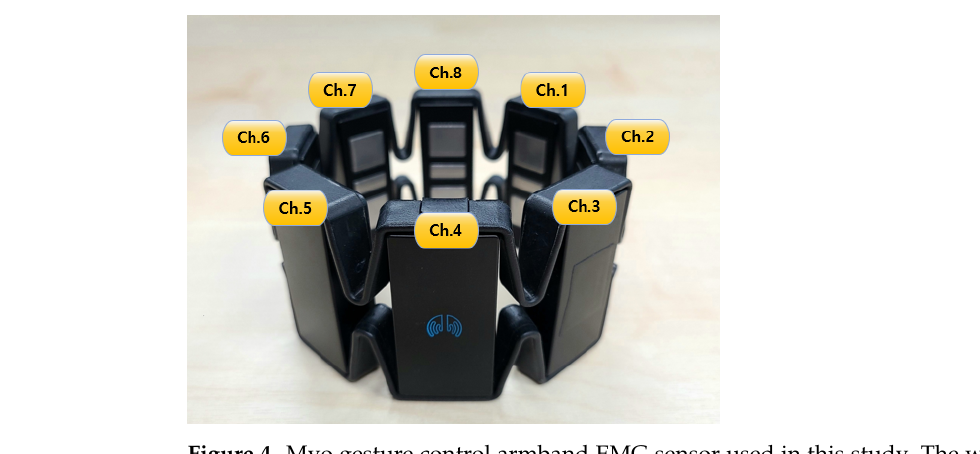
Figure 4. Myo gesture control armband EMG sensor used in this study. The wearable device has eight surface EMG channels.